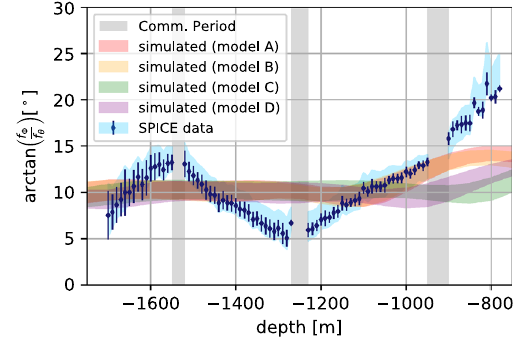
generated from NuRadioMC and propagated through the introduced birefringence model. The left side shows the polarization of the the two propagating states against the depth. The right side shows the expected traces after propagating from to the given antenna positions. The neutrinos source for all plots was set to [0m, 0m, − 1300m]. The top geometry corresponds to an antenna position of [1m, 1500m, − 1m]. The center geometry corresponds to an antenna position of [1500m, 1m, − 1m]. The bottom geometry corresponds to an antenna position of [1487m, 200m, − 1m]. In